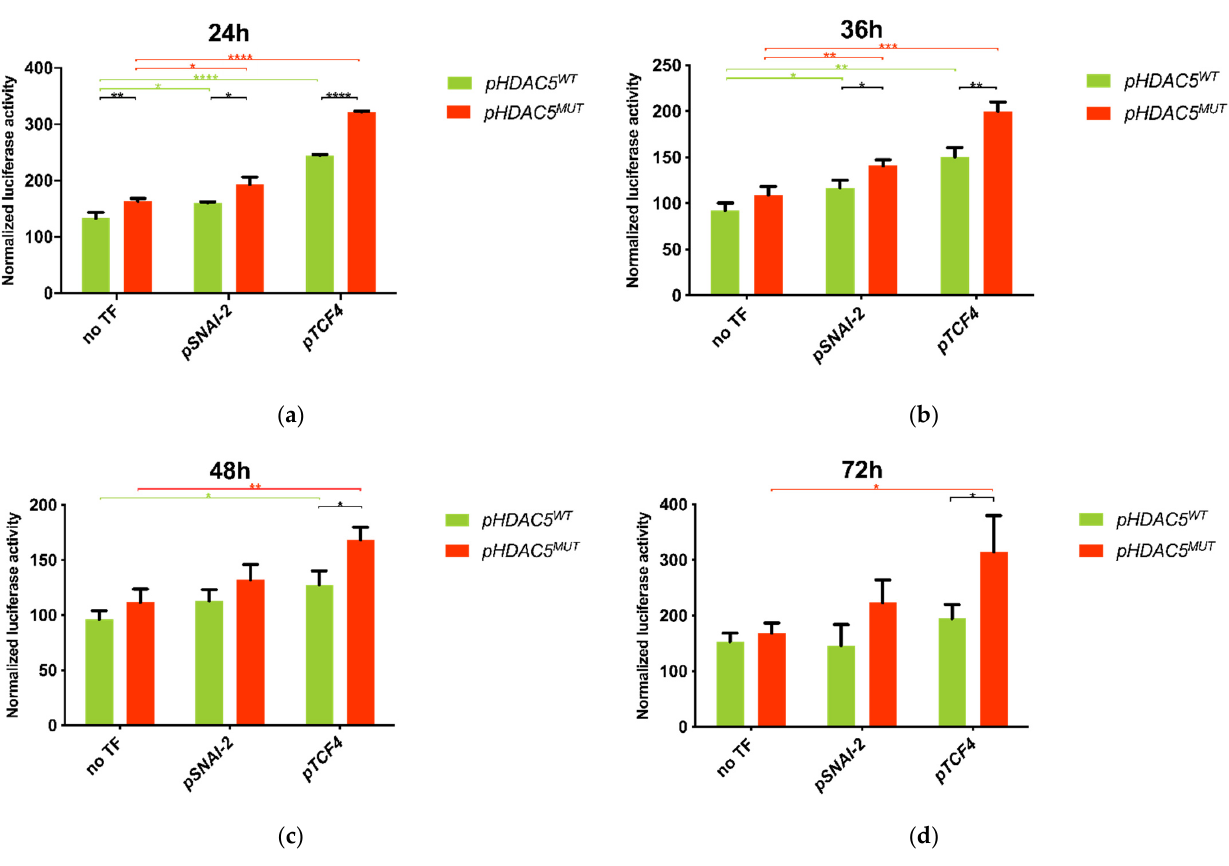
Figure 3. pHDAC5 MUT shows a significantly increased luciferase activity compared to pHDAC5 WT . Dual luciferase reporter assays performed for pGL4.10- HDAC5 WT and pGL4.10- HDAC5 MUT reporter constructs co-transfected with pSNAI-2 or pTCF4 or no transcription factor (TF) into HEK293T cells. Luciferase activity was measured at four different time points ( a – d ) and normalized to the empty pGL4.10 reporter vector. Each bar represents the mean of three independent experiments with standard deviation. pHDAC5 MUT shows a significantly increased luciferase activity compared to pHDAC5 WT . Co-transfection of pTCF4 further enhanced the promoter activity of pHDAC5 MUT significantly. *—p < 0.05, ** —p < 0.01, *** —p < 0.001, **** —p < 0.0001.